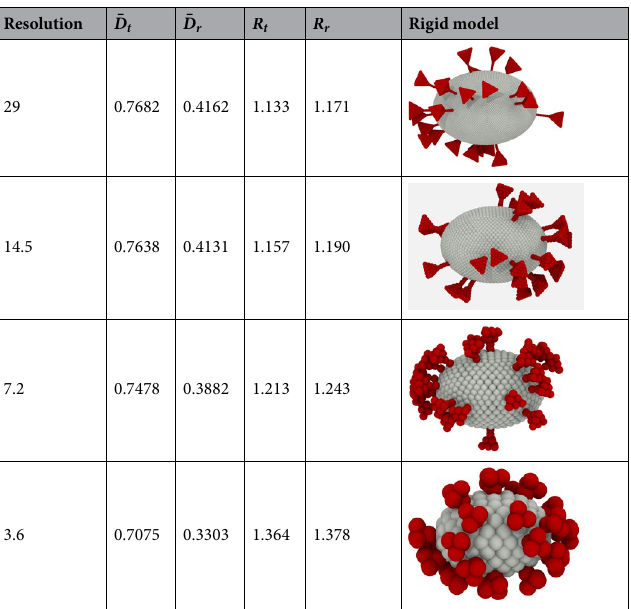
Table 3. Resolution test for SARS-CoV-2 models with N s =26 tetra-rod spikes. The spikes rod length is l s / R =0.5 and tetrahedron width is w s / R =0.31. The resolution R / r o and computed reduced coefficients are presented. Morphology of the RMB models is included for comparison. The resolution adopted in our simulations is